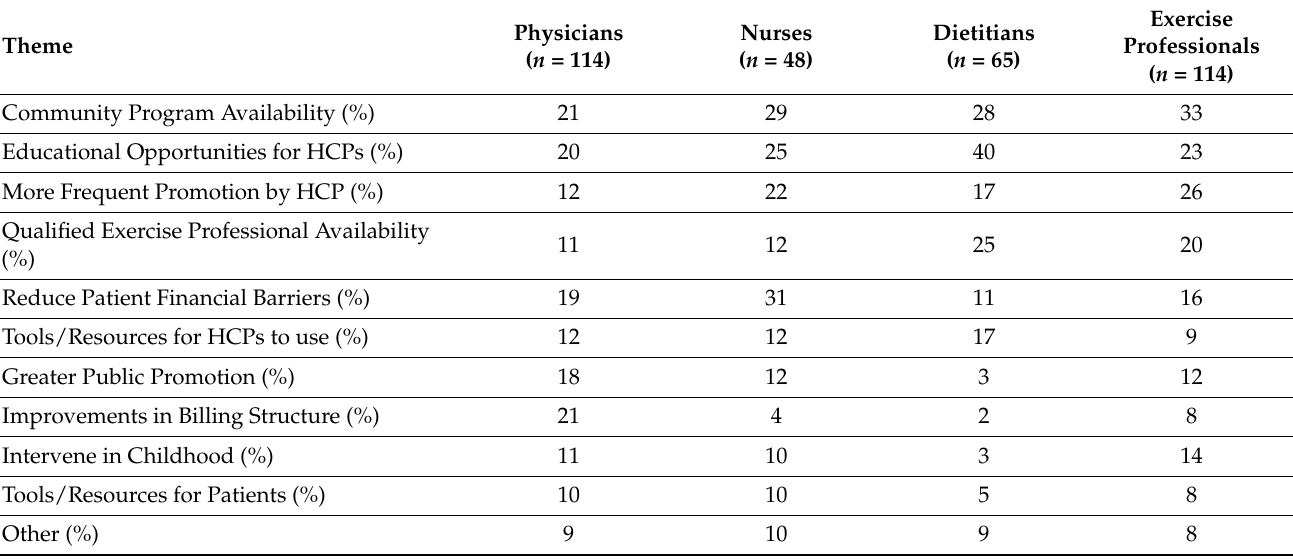
Figure 2. Summary of top 3 themes that physicians, nurses, dietitians, and exercise professionals working in Nova Scotia believe could be done to promote and sustain physical activity and exercise in health care. Each provider % (frequency of theme ÷ number of providers). Table 2. A detailed proportion of each theme across different health care providers in response to what they believe could be done to promote and sustain physical activity and exercise in health care.